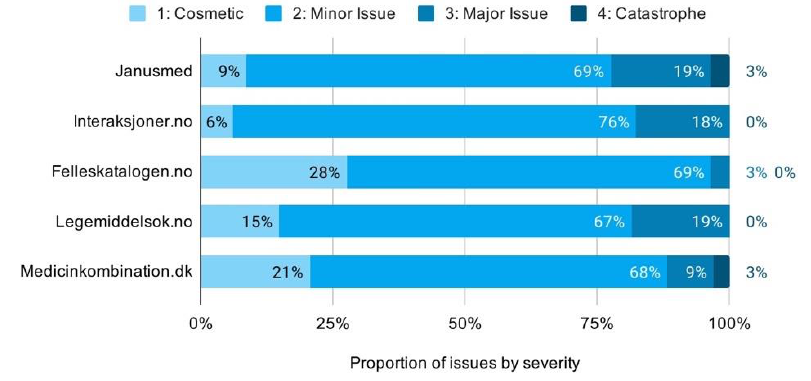
Figure 8. Proportion of usability issues by severity across services.